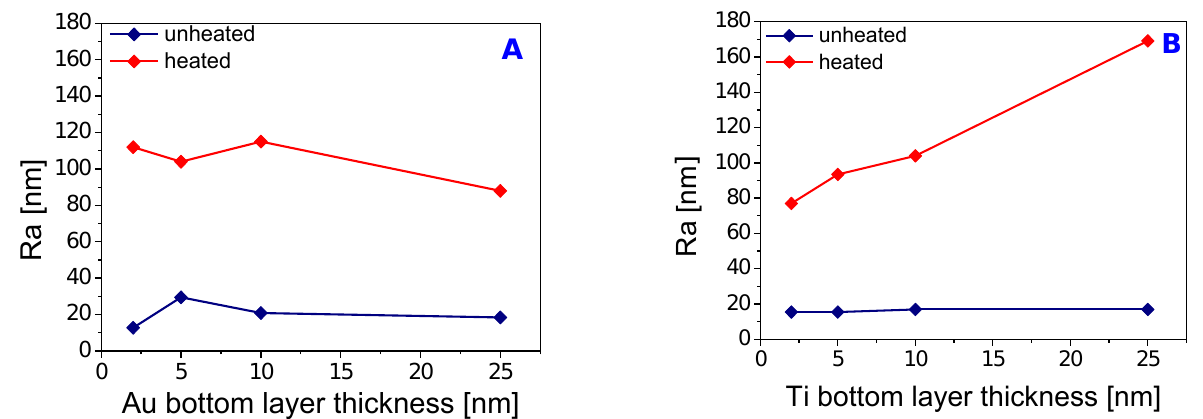
Figure 5. AFM images of the heated PLLA samples with a sputtered titanium bottom layer and a gold top layer. ( a ) Ti and Au layers of 2 and 48 nm, respectively; ( b ) Ti and Au layers of 5 and 45 nm, respectively; ( c ) Ti and Au layers of 10 and 40 nm, respectively; ( d ) Ti and Au layers of 25 and 25 nm, respectively. R a is the mean surface roughness in nanometers.